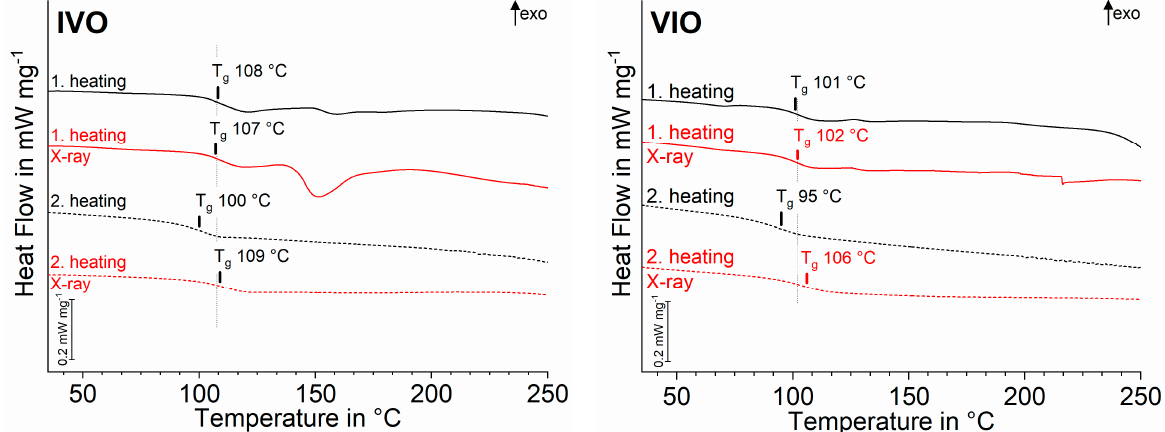
Figure 6. Stacked differential scanning calorimetry (DSC) curves and assigned glass transition temperatures (T g , midpoint) for first and second heating of PMMA-based materials exposed to X-ray irradiation during µ XCT measurements (red) and unexposed specimens (black).